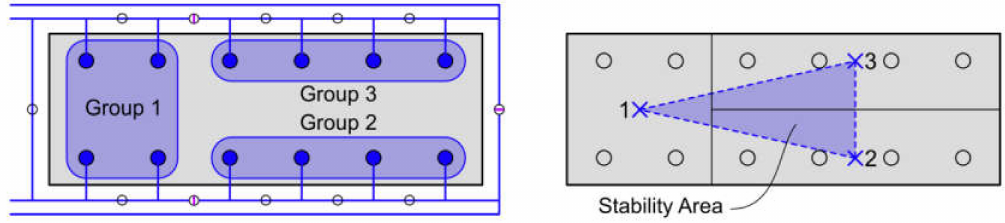
Figure 3. 3-point suspension and stability